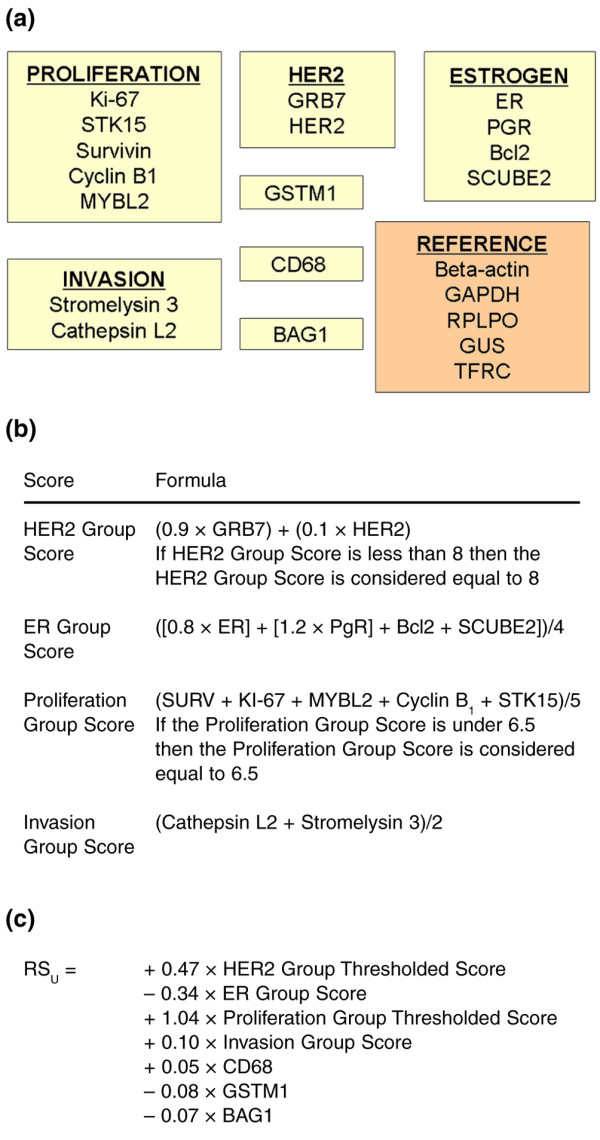
Twenty-one gene panel and calculation of recurrence score. (a) The final gene list (16 cancer-related and five reference genes) and summary score (Recurrence Score) algorithm for this assay were developed by analyzing the results of three independent preliminary breast cancer studies (for instance, training sets) with a total of 447 patients [11]. The Recurrence Score, on a scale from 0 to 100, is derived from the reference-normalized expression measurements in four steps. In the first step the expression for each gene is normalized relative to the expression of the five reference genes (b-actin, GAPDH, GUS, RPLPO, and TFRC). Reference-normalized expression measurements range from 0 to 15, where a 1-unit increase reflects approximately a twofold increase in RNA. (b) In the second step the HER2 Group Score, the ER Group Score, the Proliferation Group Score, and the Invasion Group Score are calculated from individual gene expression measurements. (c) In the third step the Recurrence Score unscaled (RSU) is calculated using coefficients that were pre-defined based on regression analysis of gene expression and recurrence in the three training studies (Providence, Rush, and NSABP B-20 [12]). A plus sign indicates increased expression is associated with increased recurrence risk. A minus sign indicates that increased expression is associated with decreased recurrence risk.